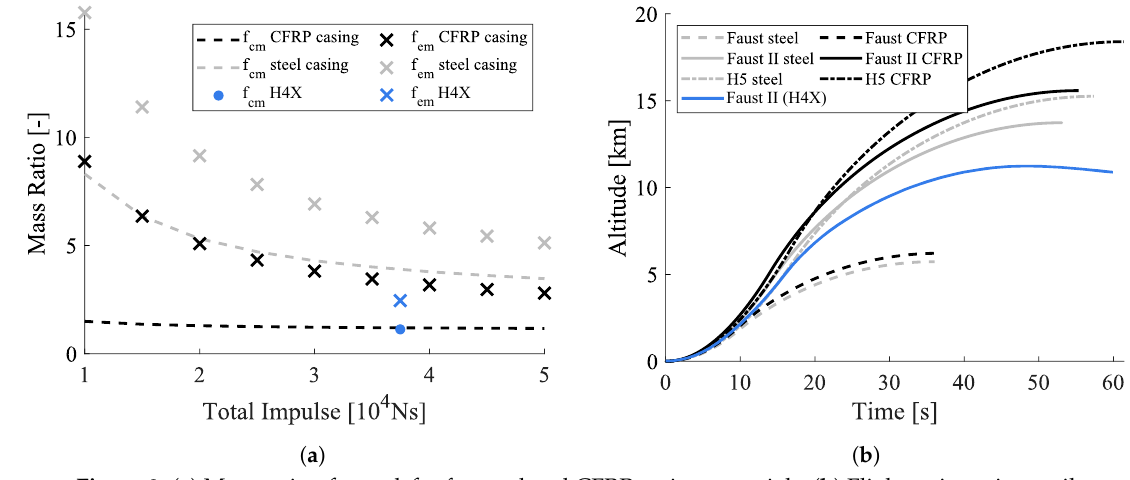
Figure 9. ( a ) Mass ratios f cm and f em for steel and CFRP casing materials; ( b ) Flight trajectories until apogee altitude for three different rocket designs, again with steel or CFRP casing